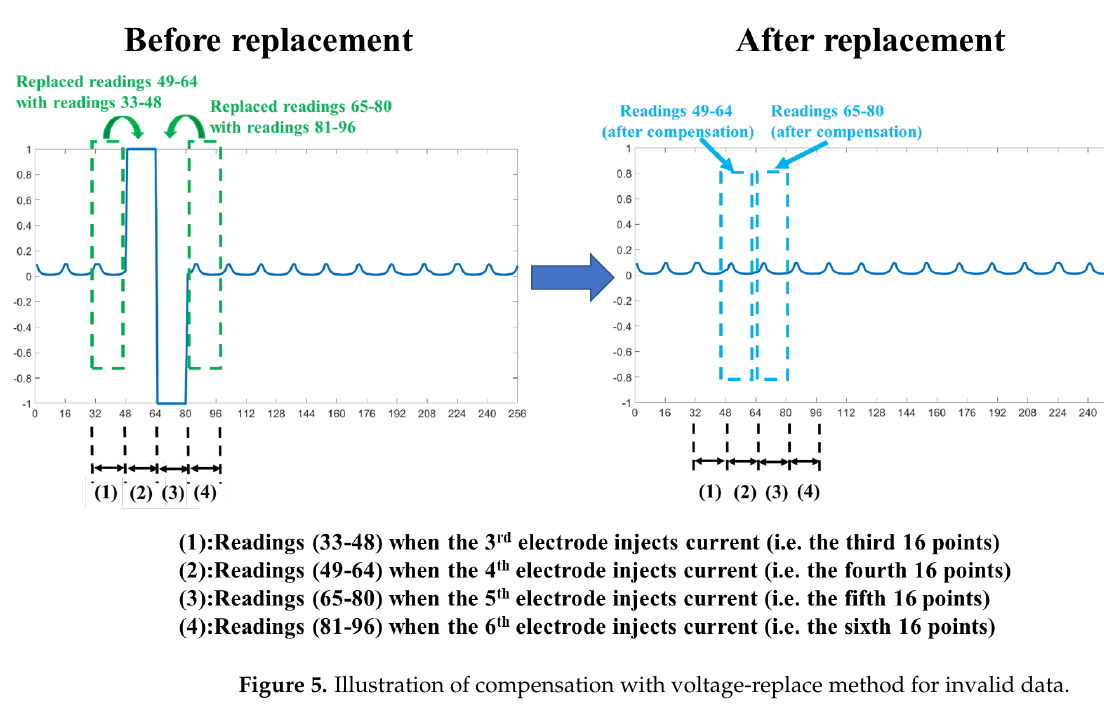
Figure 5. Illustration of compensation with voltage-replace method for invalid data.